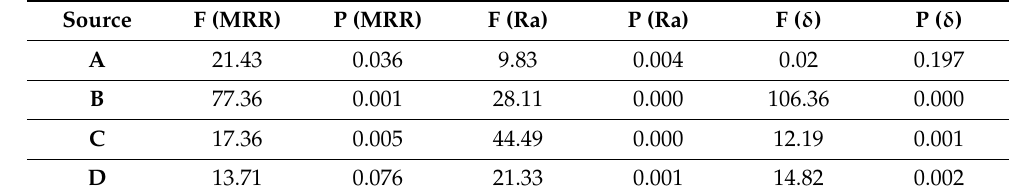
Table 6. ANOVA for MRR, Ra, and δ .